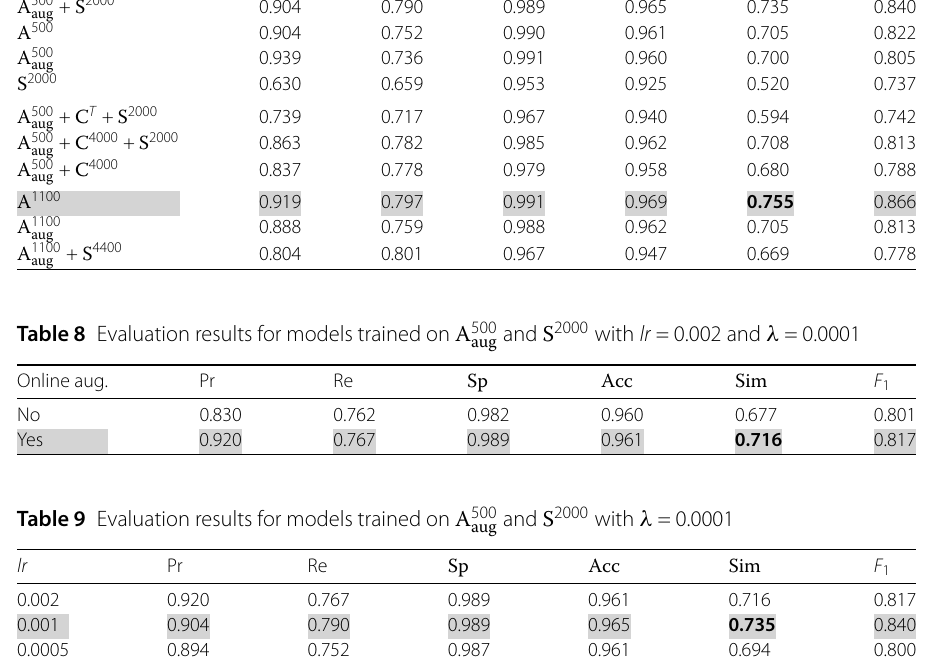
Table 7 Evaluation results for models trained on different datasets by applying online augmentation with the parameters lr = 0.001 and λ = 0.0001